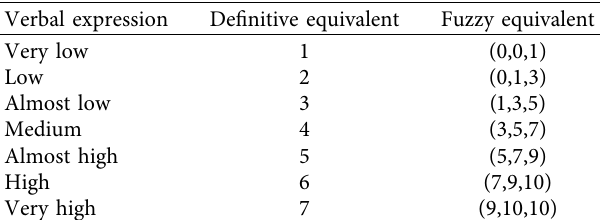
Table 3: Verbal expressions and definite and fuzzy